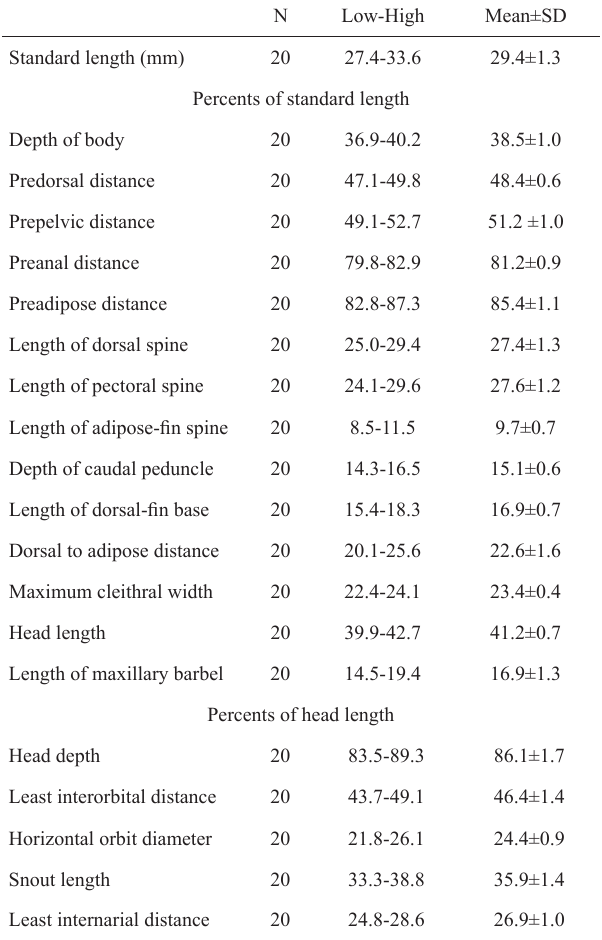
Table 1. Morphometric data of Corydoras guapore. N = number of specimens and SD = standard